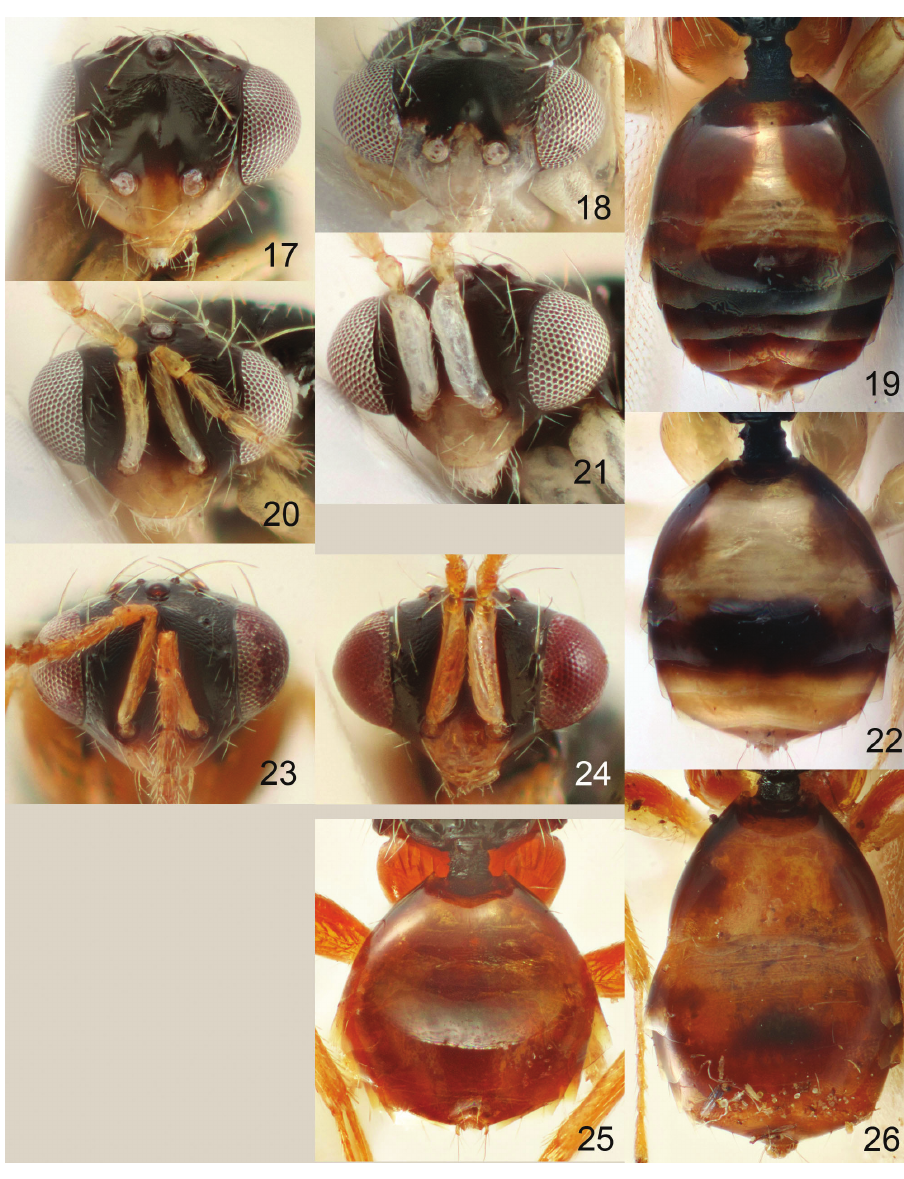
Figures 17–26. Euplectrus spp.: 17–19 E. geometricida sp. n., paratypes 17 head frontal, female 18 head frontal, male 19 gaster dorsal, female 20–22 E. carinifer sp. n., paratypes 20 head frontal, female 21 head frontal, male 22 gaster dorsal, female 23–26 E. pallidigaster sp. n., paratypes 23 head frontal, female 24 head frontal, male 25 gaster dorsal, female 26 gaster dorsal, rache, (3), 11.viii.1976”. ITALY (2 ♀ ): 1 ♀ ”ITALY, Malcesine, 200–300m, 23.4.1977, leg. V. Vikberg” (MZH); 1 ♀ “ITALIA: Varazze, nr Genova, 4.IX.71, Bouček” (NHM). SPAIN (1 ♀ ): ”SPAIN: Barcelona, Calella d. Costa, VI.1971, Bouček” (NHM).